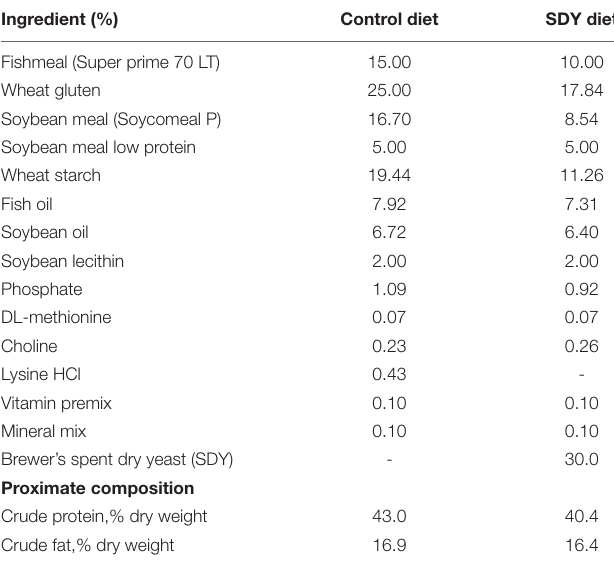
TABLE 1 | List of ingredients and proximal composition of experimental diets used for evaluating the inclusion of Brewer’s spent dry yeast (SDY) in compound diets for gilthead sea bream ( Sparus aurata